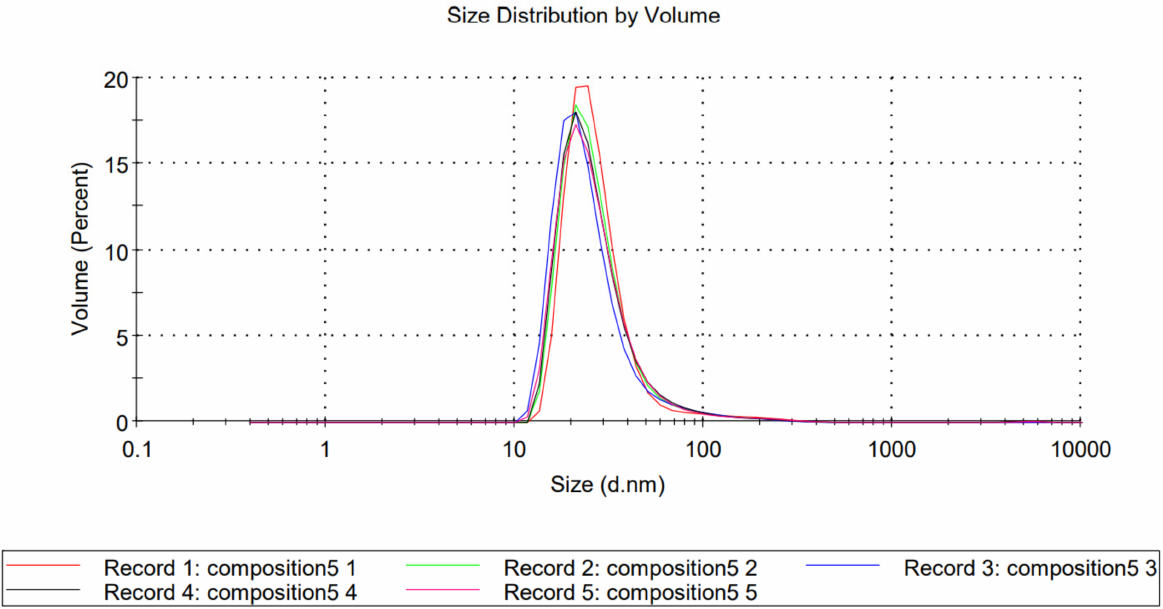
Figure 1. Size distribution by volume of TFG + S1. Each measurement consisted of 10 individual test runs. Average particle diameter was calculated by the software of the equipment.